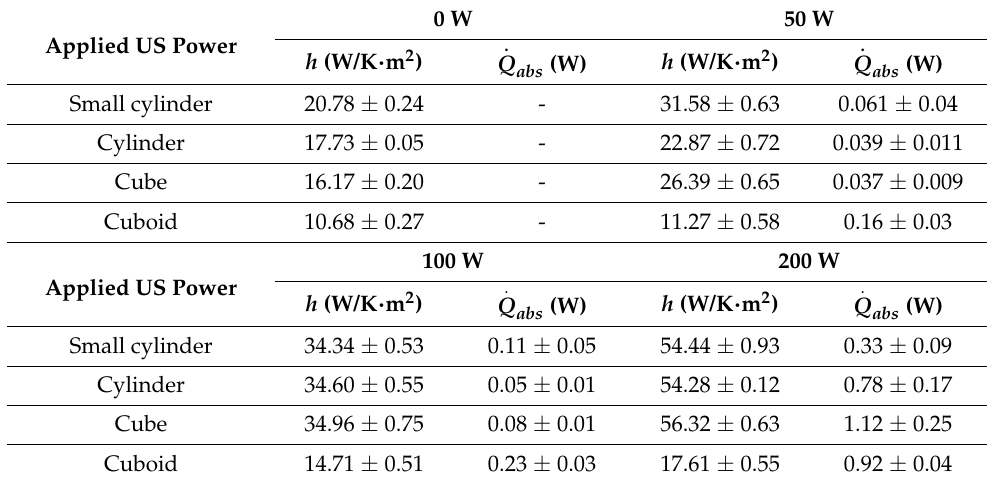
Table 4. Results of heating in temperature 60 ◦